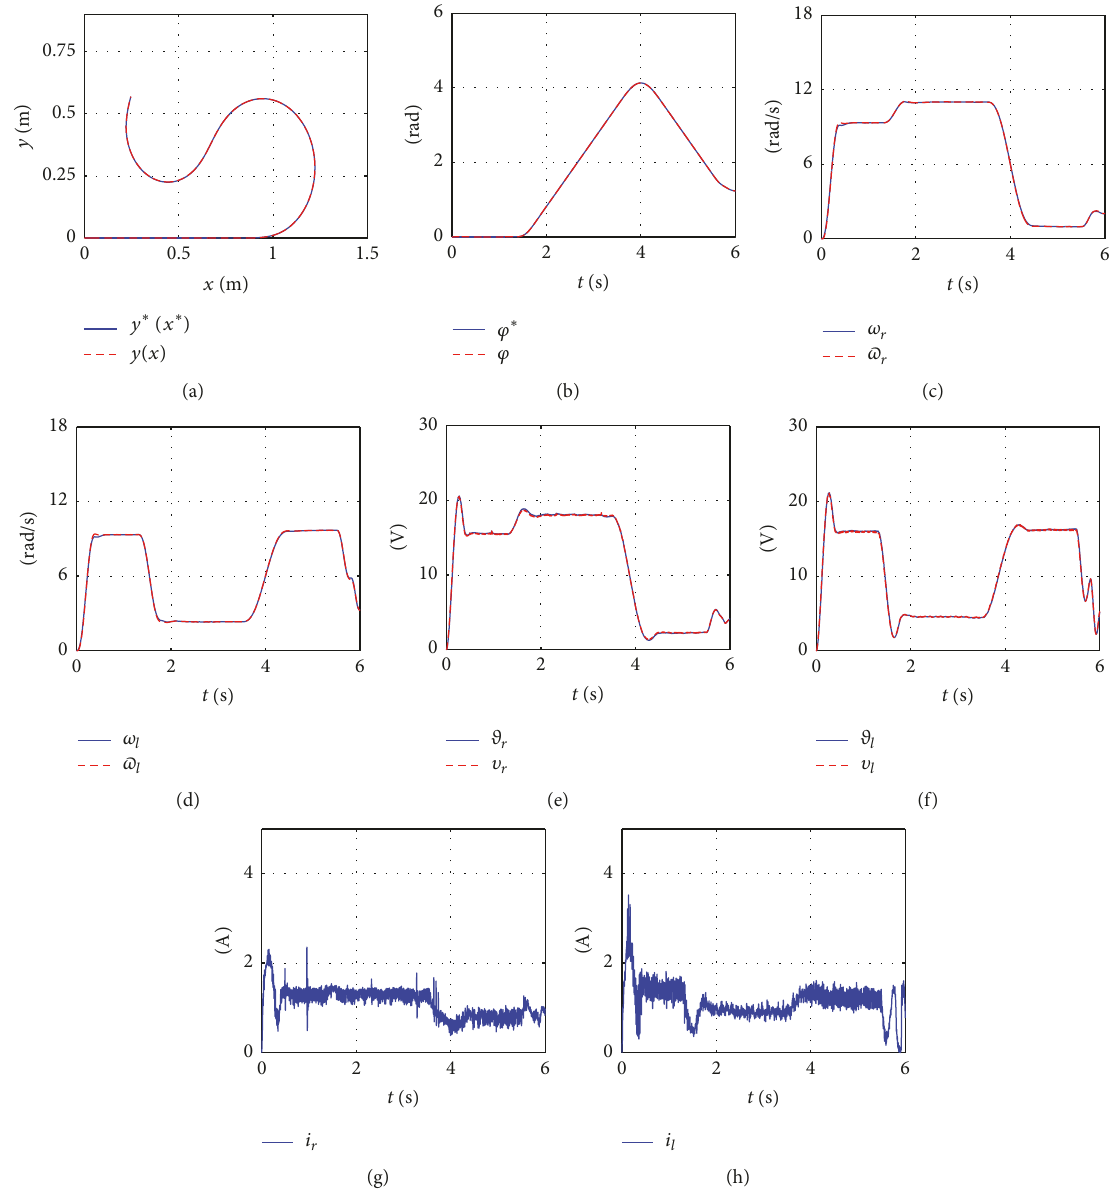
Figure 6: Experimental results when uncertainties exist in 𝐸 𝑟 and 𝐸 𝑙